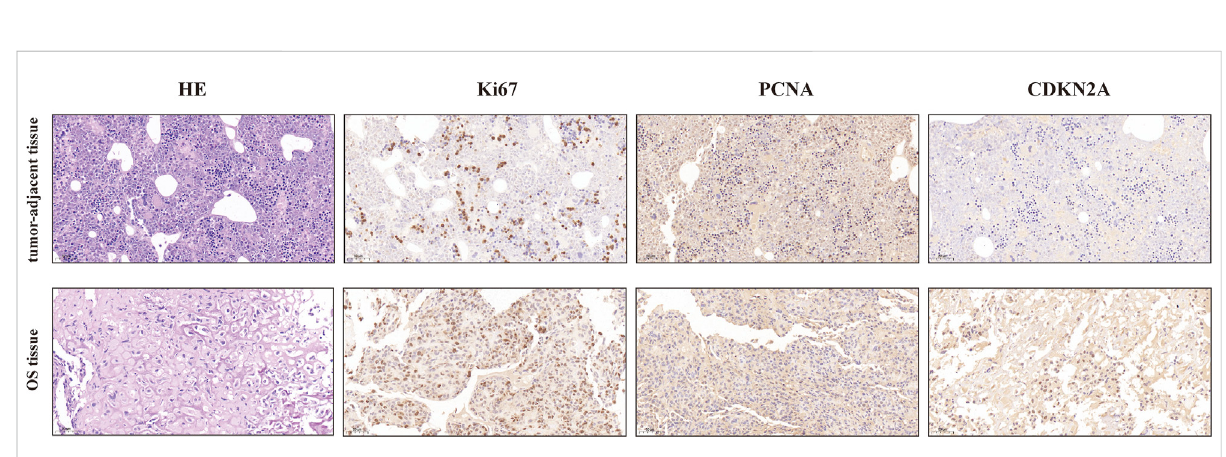
FIGURE 11 IHC analysis of ki-67, PCNA, and CDKN2A in OS and tumor-adjacent tissues (Magni fi cation, ×200, scale bars indicated 50 μ